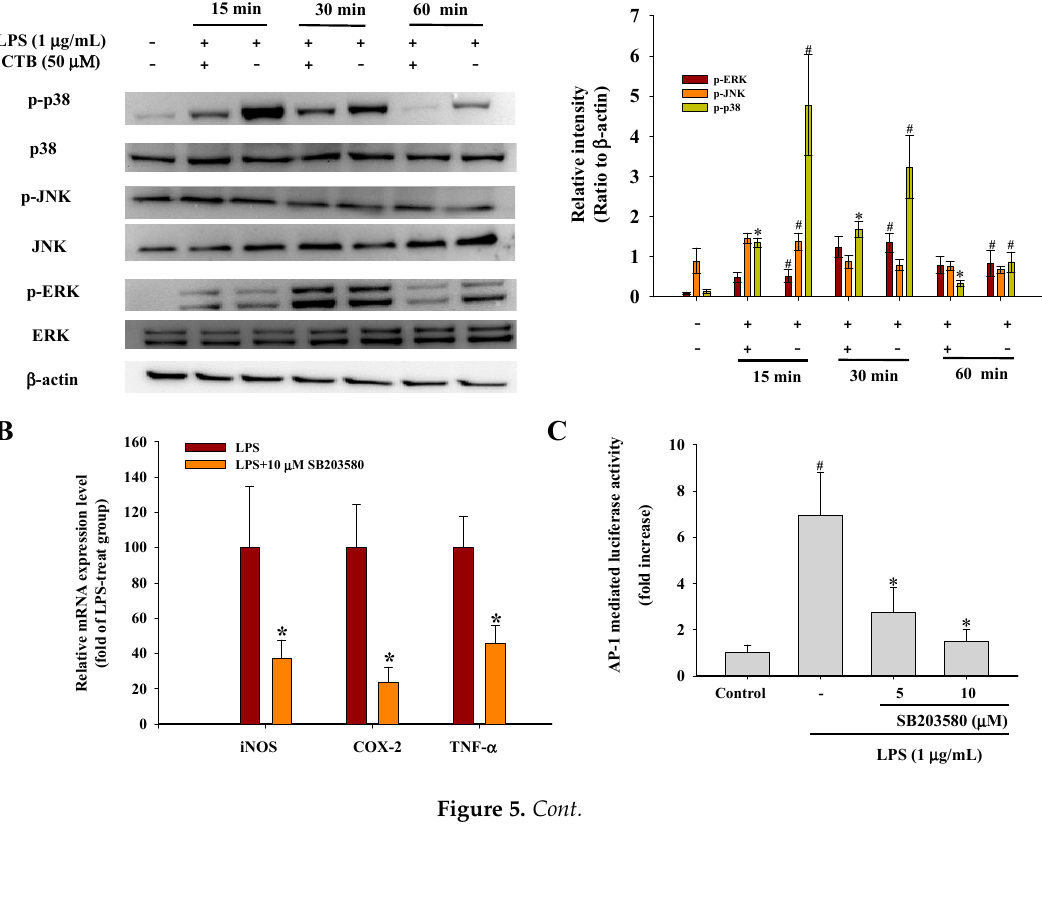
Figure 5. Cont. Figure 5.